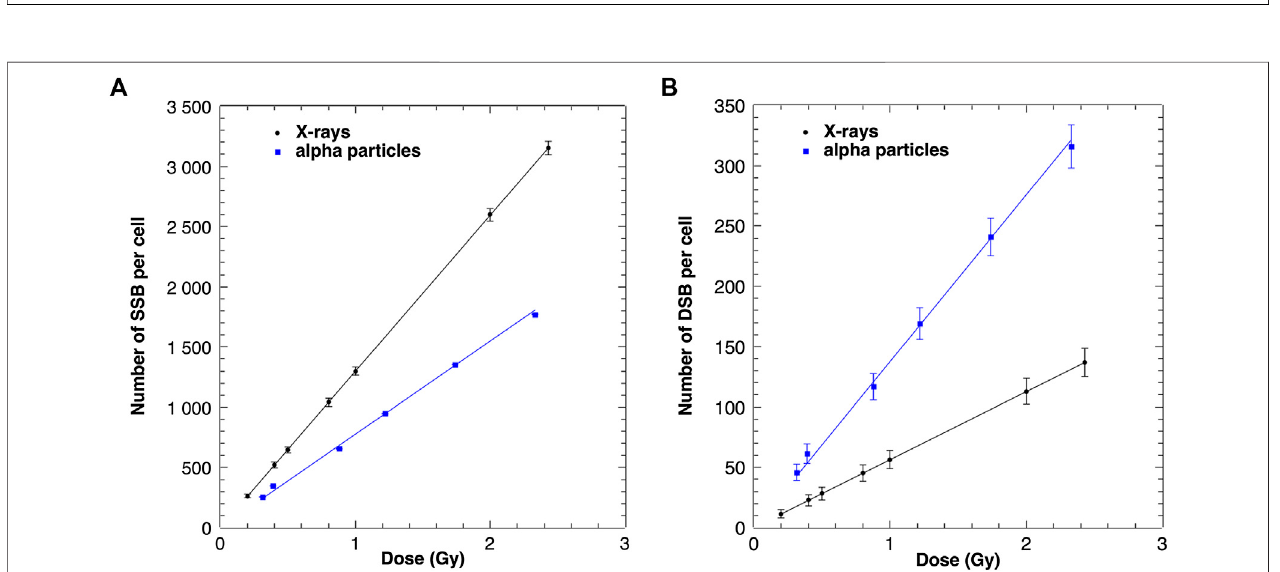
FIGURE 1 | The simulated spatial ionization distribution within an exemplary lymphocyte nucleus after X-ray (left panel) and alpha irradiation (right panel) with the dose equal 1 Gy.